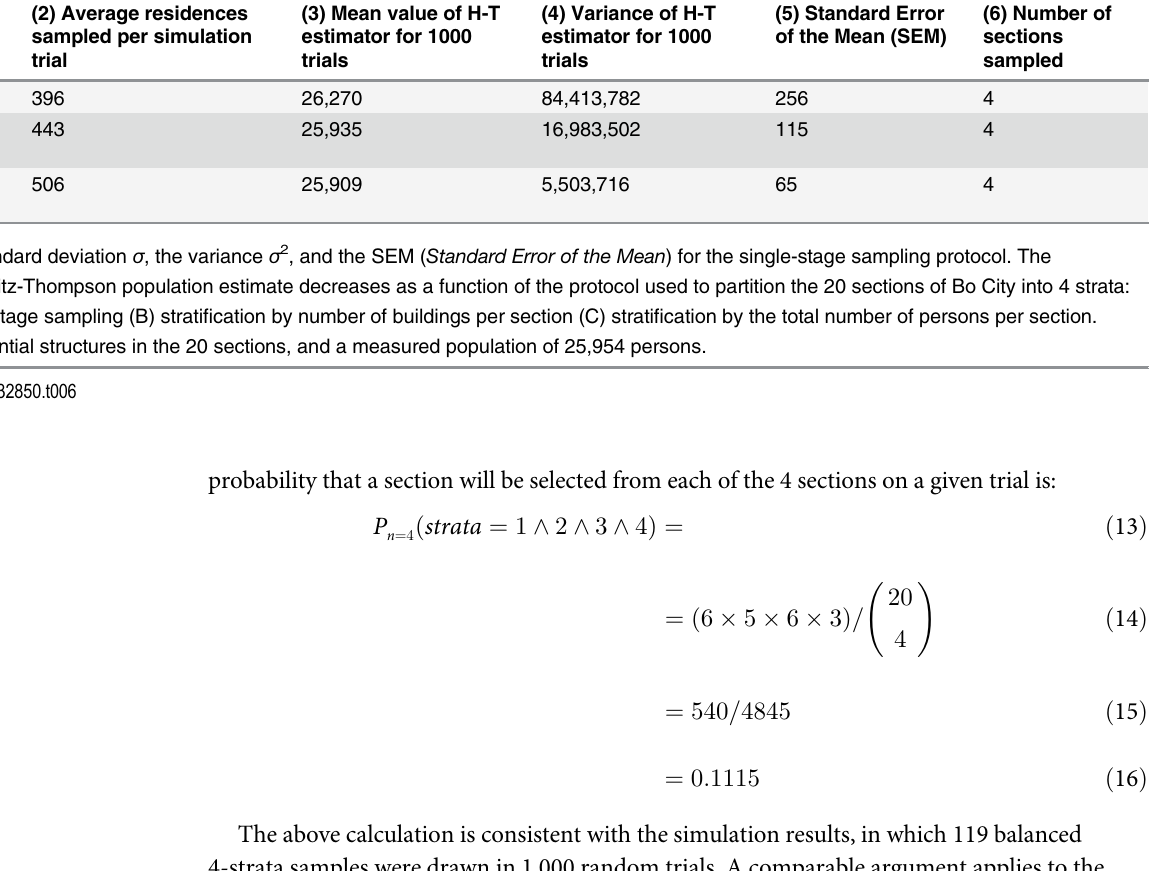
Table 6. A comparison of simulation results for single-stage cluster sampling.